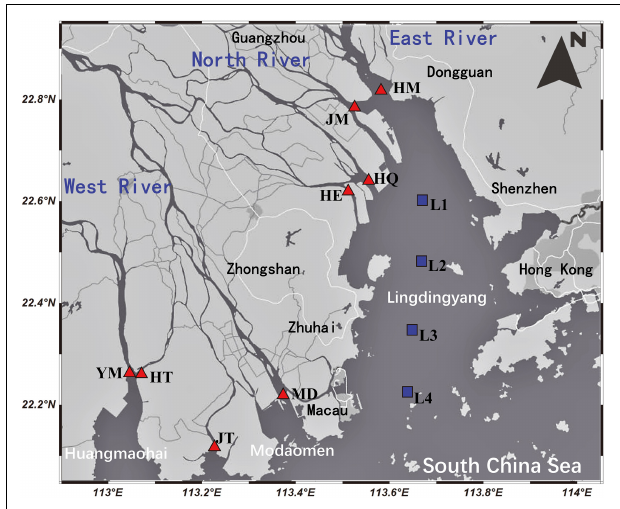
FIGURE 1 | Study area and sampling sites of the PRE. The sampling sites at eight outlets and the Lingdingyang Bay are marked with red triangles and blue squares,